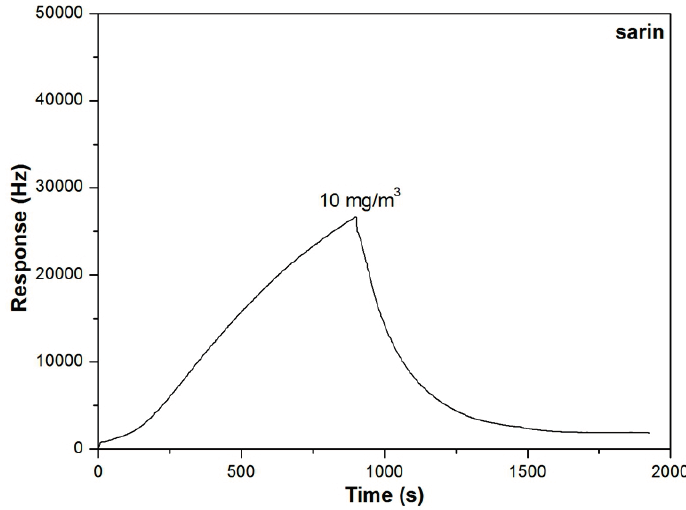
Figure 4. Response of the sensor to sarin at the concentration of 10 mg/m 3 (16 min sarin and 16 min N 2